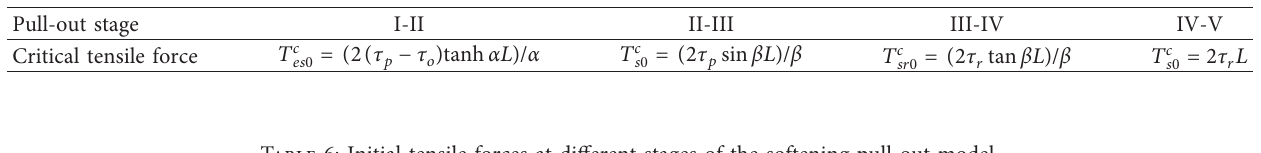
Table 5: Critical tensile force between the two stages of the softening pull-out model.